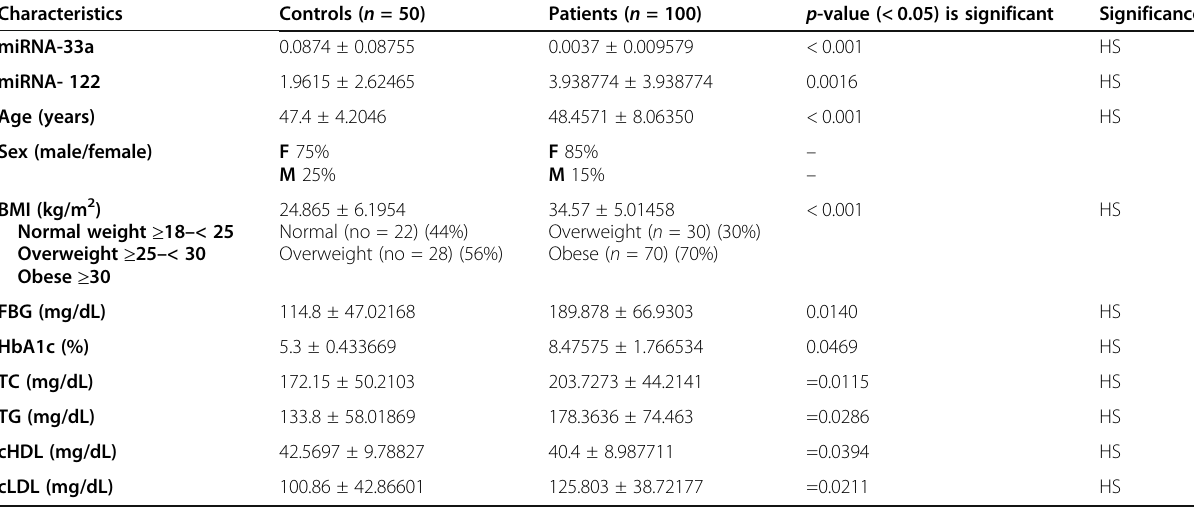
Table 1 Anthropometric measurements and laboratory findings among the study participants Characteristics